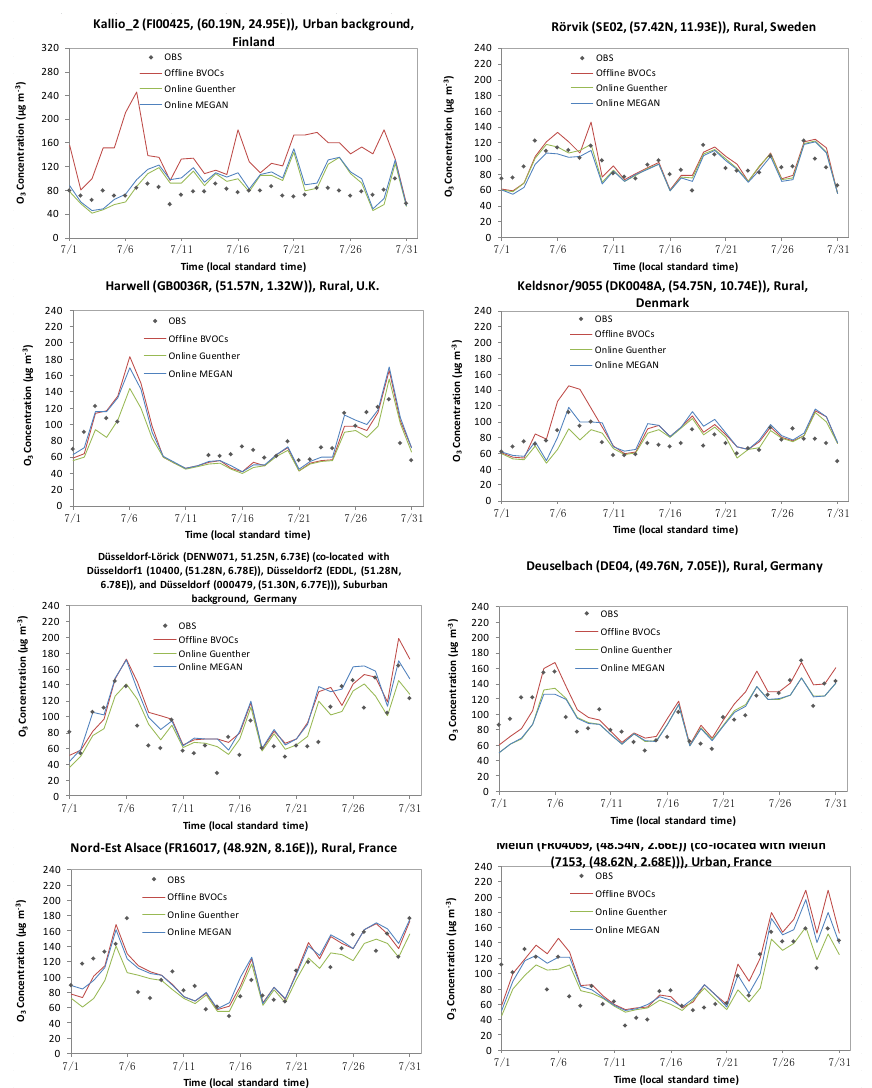
Figure 12. Simulated and observed concentrations of max 8-hr O 3 over D01 from WRF/Chem- Fig. 12. Simulated and observed concentrations of max 8h O 3 over D01 from WRF/Chem-MADRID using offline BVOC emissions of MADRID using offline BVOCs emissions of Simpson et al. (1999) and online BVOCs emission modules based on modified Guenther (Guenther et al., 1995) and MEGAN Simpson et al. (1999) and online BVOC emission modules based on modified Guenther (Guenther et al., 1995) and MEGAN (Guenther et (Guenther et al., 2006) in July 2001 at selected sites over D01. al., 2006) in July 2001 at selected sites over